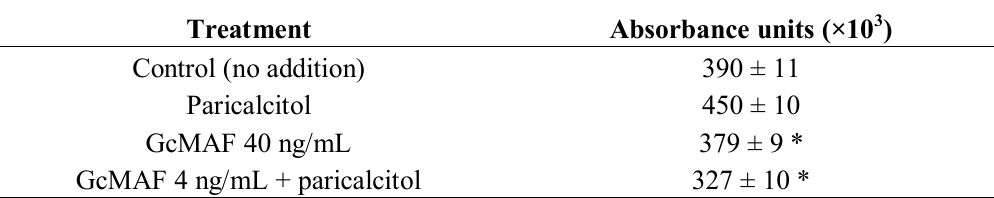
Table 1. Effects of GcMAF and paricalcitol on Raw 264.7 macrophages. Raw 264.7 cells were incubated for 30 min with indicated additions. The effects of GcMAF on macrophage activation were assessed by determining cell proliferation. In fact, it was demonstrated that monocytes/macrophages activated by GcMAF administration immediately stop DNA replication and rapidly synthesize a large amount of Fc-receptors as well as an enormous variation of receptors [28]. Paricalcitol was added at the concentration of 300 fg/mL. At this concentration, paricalcitol did not exert any effect. In the presence of paricalcitol (300 fg/mL), the effect of 4 ng/mL GcMAF was identical to that of 40 ng/mL GcMAF in the absence of paricalcitol. These results demonstrate that the presence of a selective VDR agonist at a concentration that is not sufficient to activate VDR per se increases by an order of magnitude the response to GcMAF. Data are presented as means ± S.E.M. ( n = 12). * p < 0.02 vs.